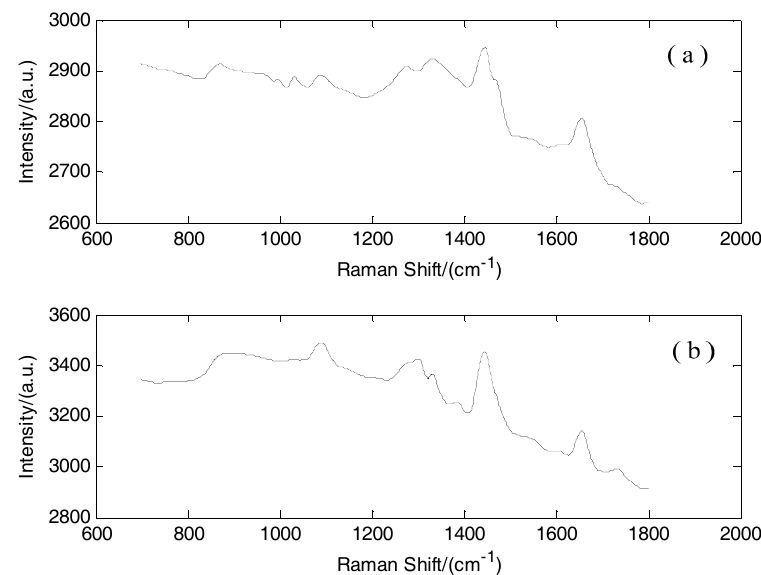
Figure 2. ( a ) Raman spectrum of cancerous tissue after wavelet transforms; ( b ) Raman spectrum of normal tissue after wavelet transforms.